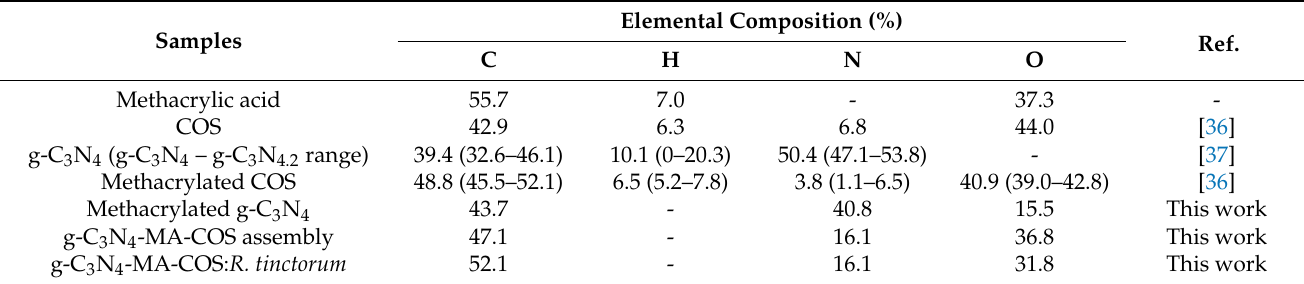
Table 1. EDX elemental analysis